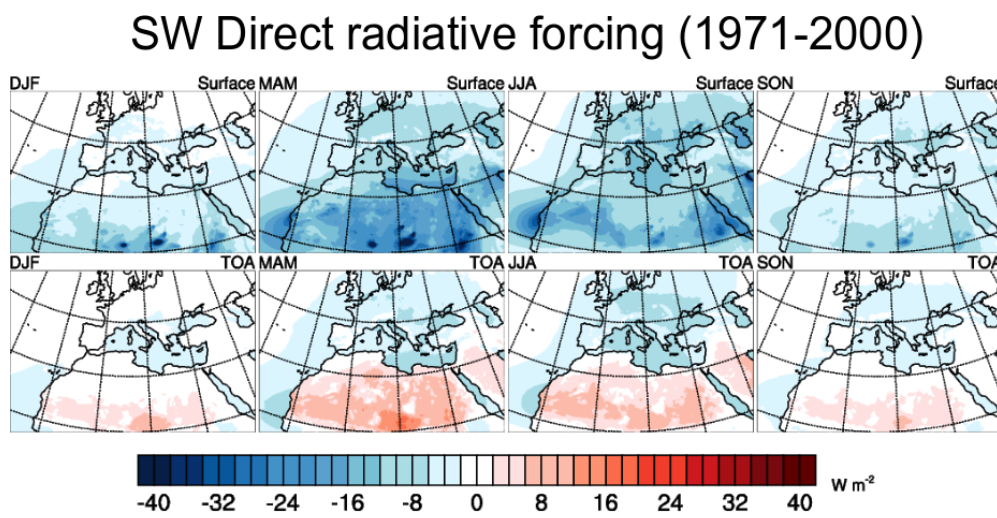
Figure 8. Mean SW DRF (Wm − 2 ) of all aerosols over the period 1971–2000 at the surface and at the TOA.